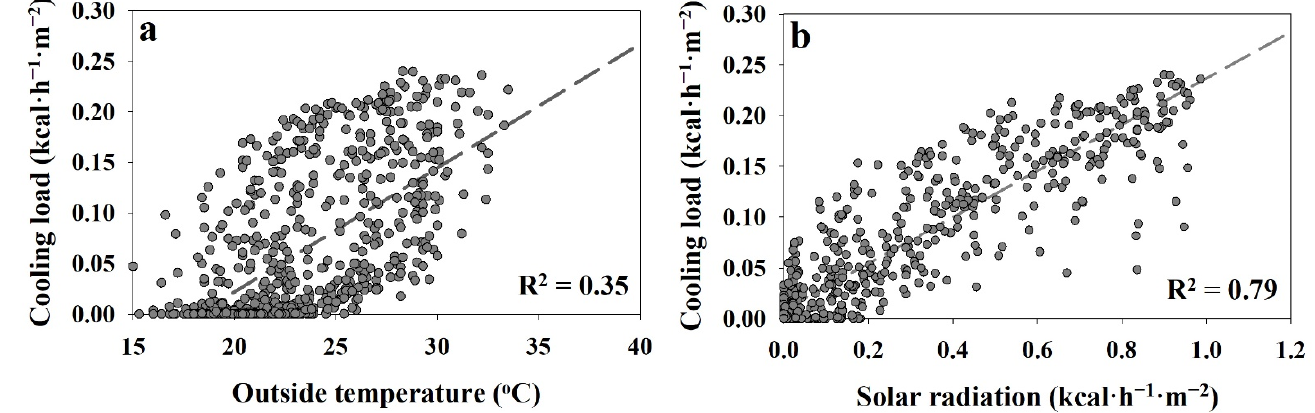
Figure 13. Linear regression analyses of monthly cooling load vs. ( a ) solar radiation and ( b ) ambient temperature .